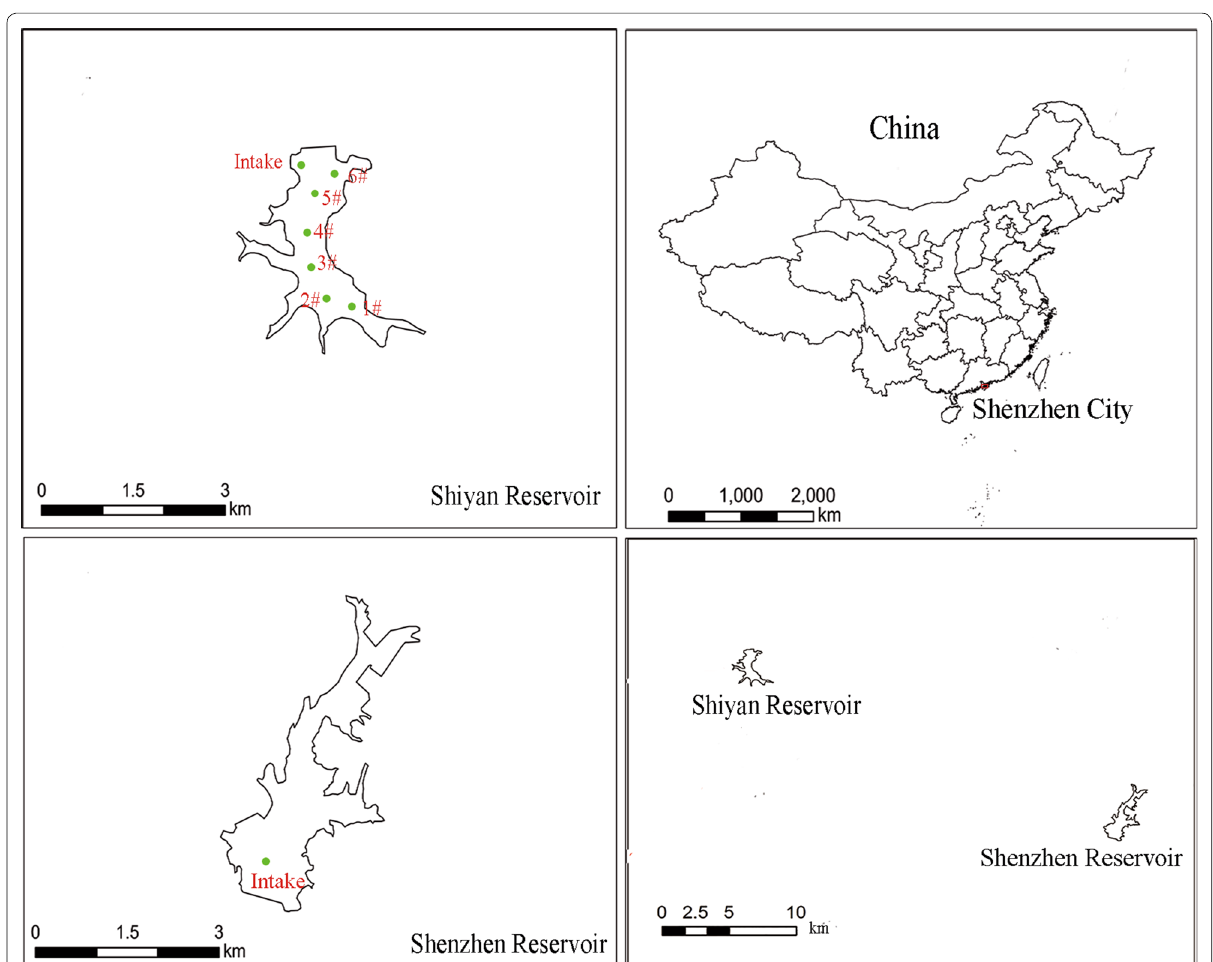
Fig. 1 The sampling sites in Shiyan reservoir and Shenzhen reservoir